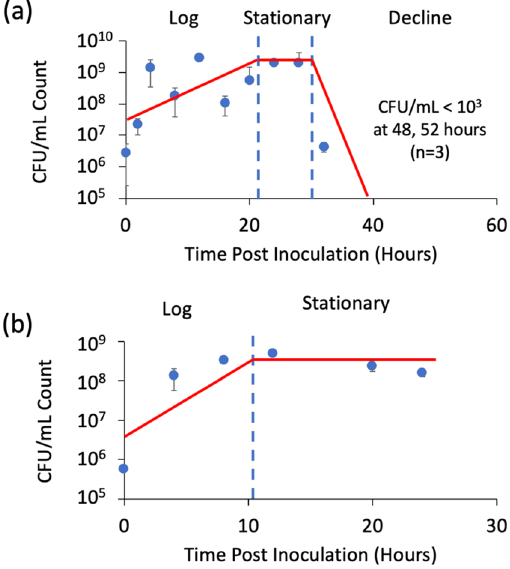
Figure 3. Growth curves of ( a ) F. tularensis novicida in modified Mueller-Hinton media over a 52-hour time period and ( b ) B. anthracis Sterne in Brain-Heart Infusion media over a 24-hour time period. Data points and error bars represent the means and standard deviations of CFU/mL determined from three culture replicates. Red curves represent trends in bacterial growth and indicator of growth